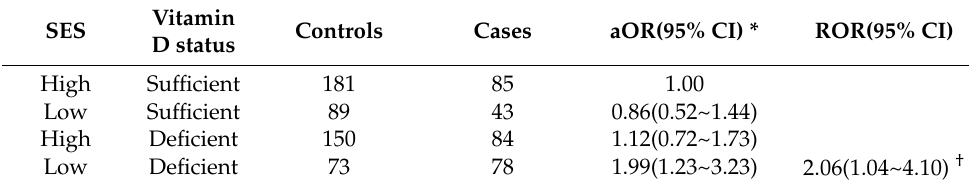
SES index, socio-economic status index; ROR: ratio of odds ratio. * Multi-level logistic regression models adjusted for body mass index, history of chronic diseases, passive smoking, meat intake, milk intake and accepting community maternal-new-born health promotion services. † P interaction <